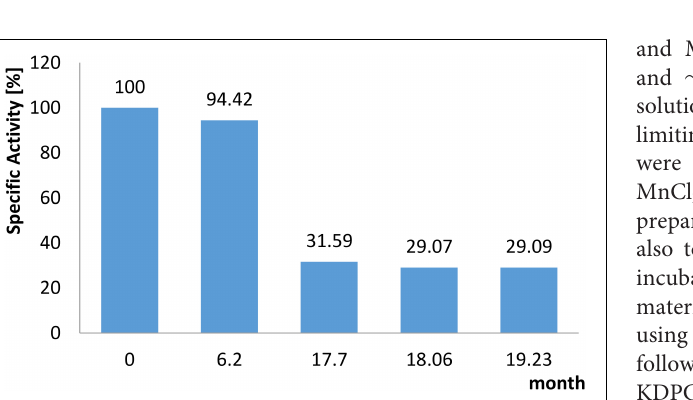
FIGURE 4 | Long term stability of the recombinant Cc EDD. The enzyme was stored at –80 ◦ C in a buffer composed of HEPES/KOH, pH 8, 25% (v/v) glycerol, 5 mM MnCl 2 . The residual activity was determined at the time points indicated using the continuous assay as described in section “Materials and